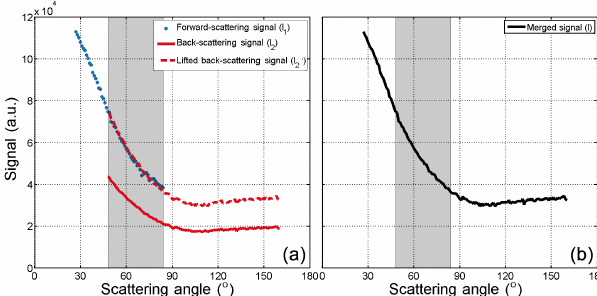
Figure 3. Signal merging of two CCD cameras. Besides the signals captured by the first CCD (blue dotted line) and the second CCD (red solid line), the lifted signal from the second CCD (red dashed line) is also shown in the left drawing. The merged signal is shown in the right